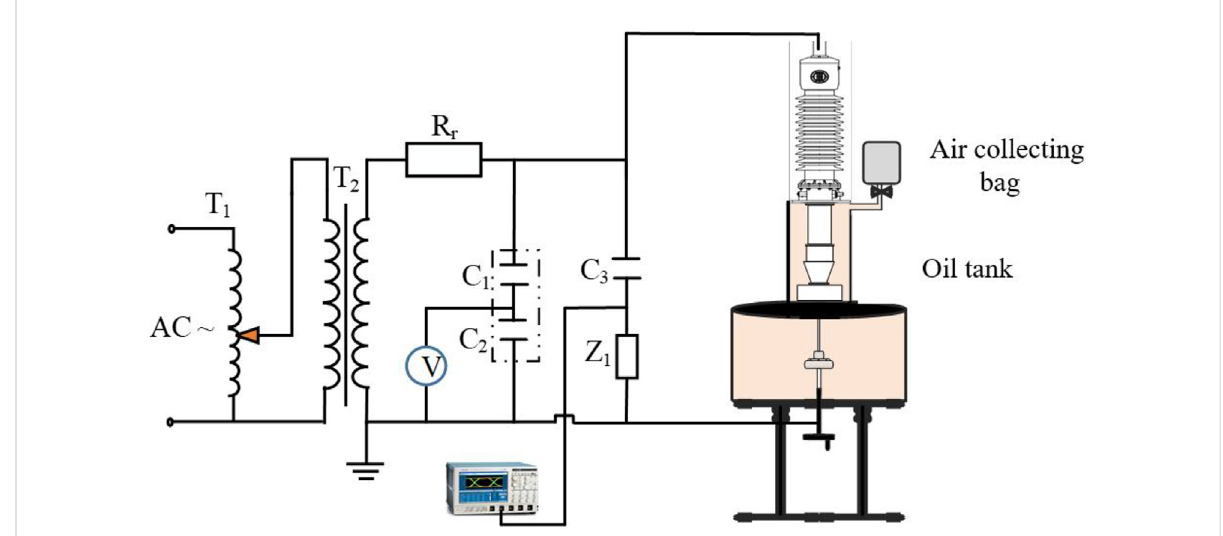
FIGURE 1 Analog experimental circuit for free gas detection of sudden and serious discharge fault of